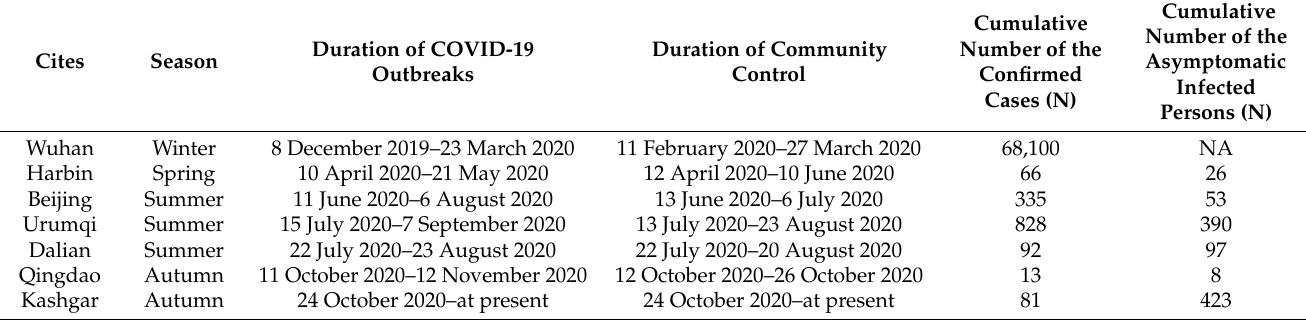
Table 1. Summary of COVID-19 outbreak information for selected cities in China (after December 2019).